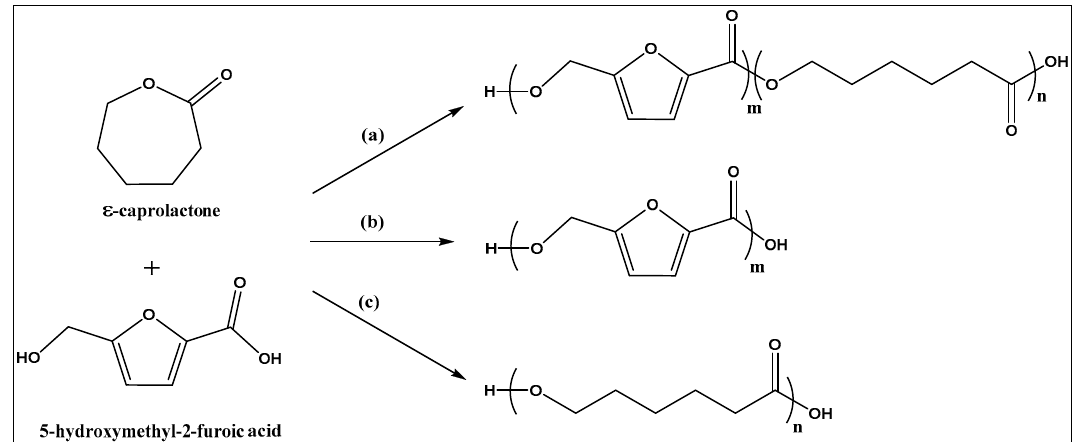
Figure 1. Reaction scheme for the polyester synthesis from 5-hydroxymethyl-2-furancarboxylic acid and ε -caprolactone, with formation of linear copolymer (route a) and homopolymer (route b and c) products.